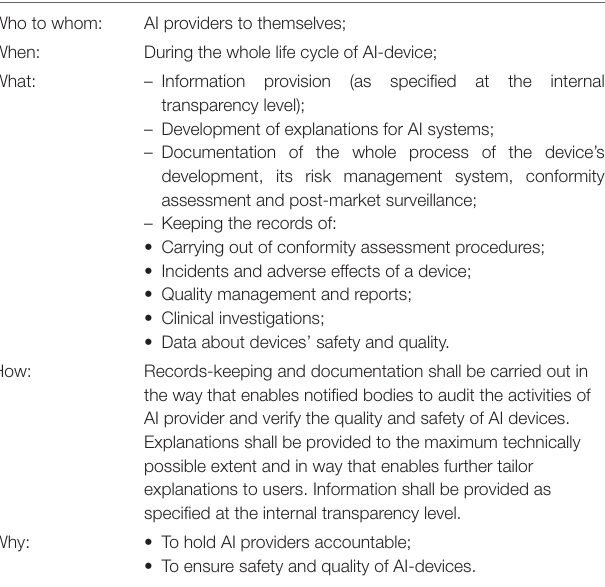
TABLE 3 | Summary of the MDF requirements (illustrated by the MDR) relevant to AI’ insider transparency measures. Who to